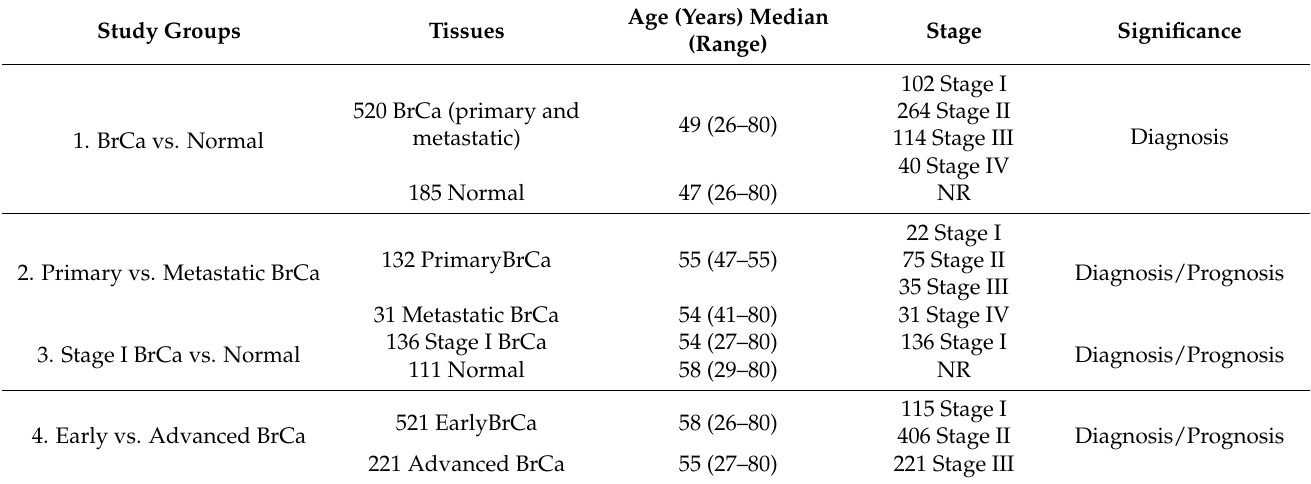
Table 6. Comparisons, endpoints, study group characteristics, and clinical significance of the